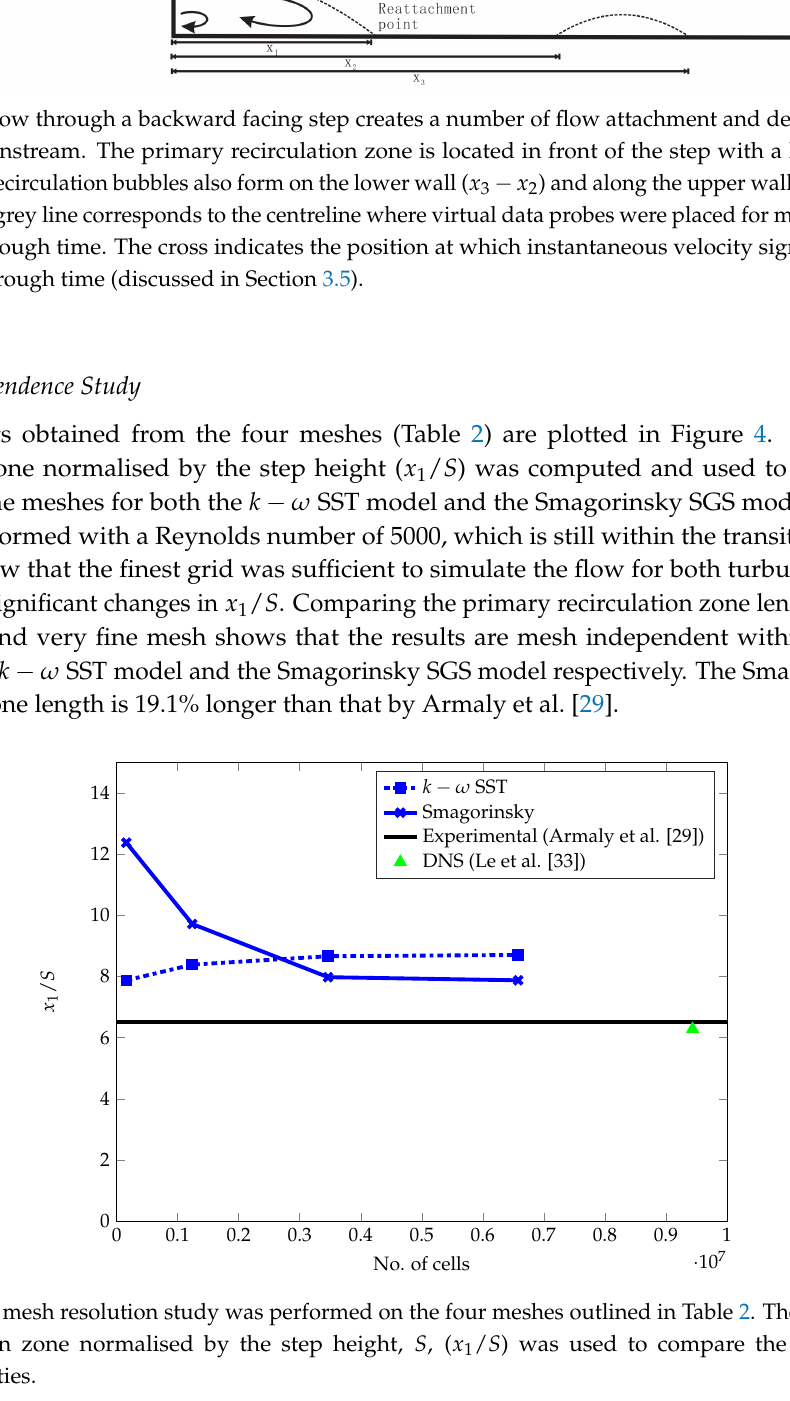
x 2 ) and along the upper wall ( x 5 x 4 ). − −